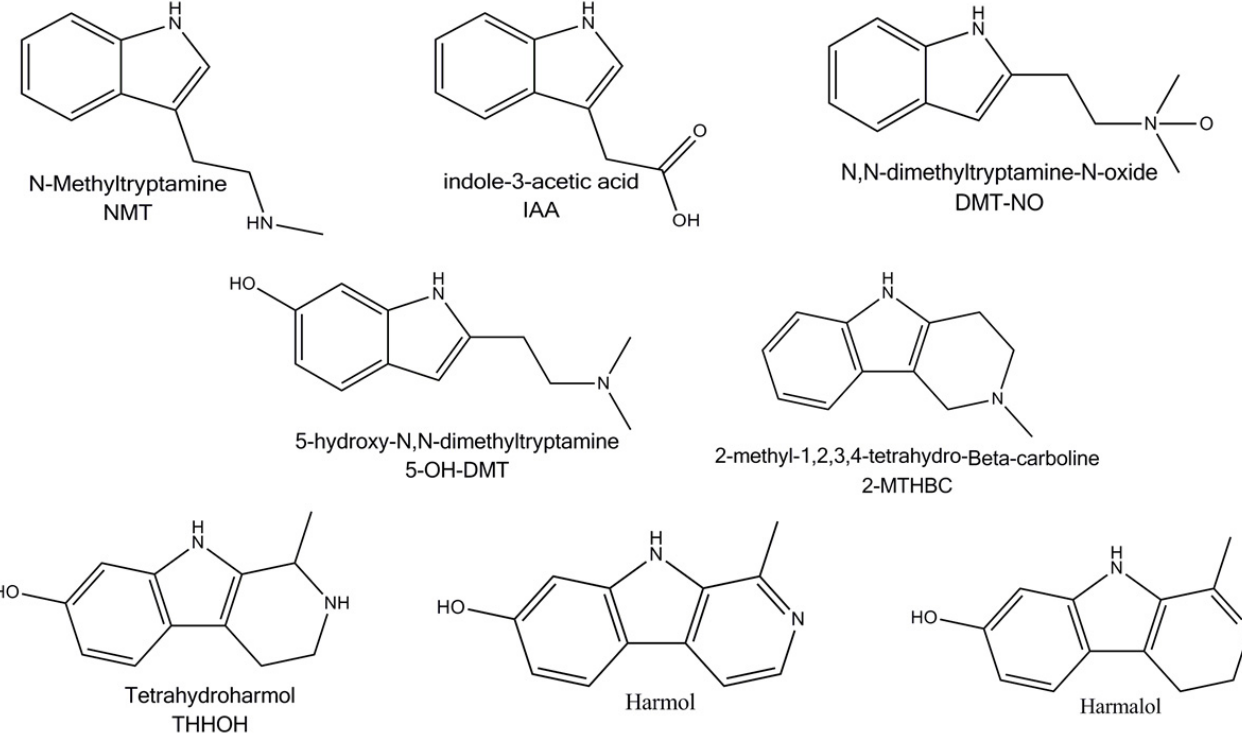
Figure 2. Metabolites of Ayahuasca.